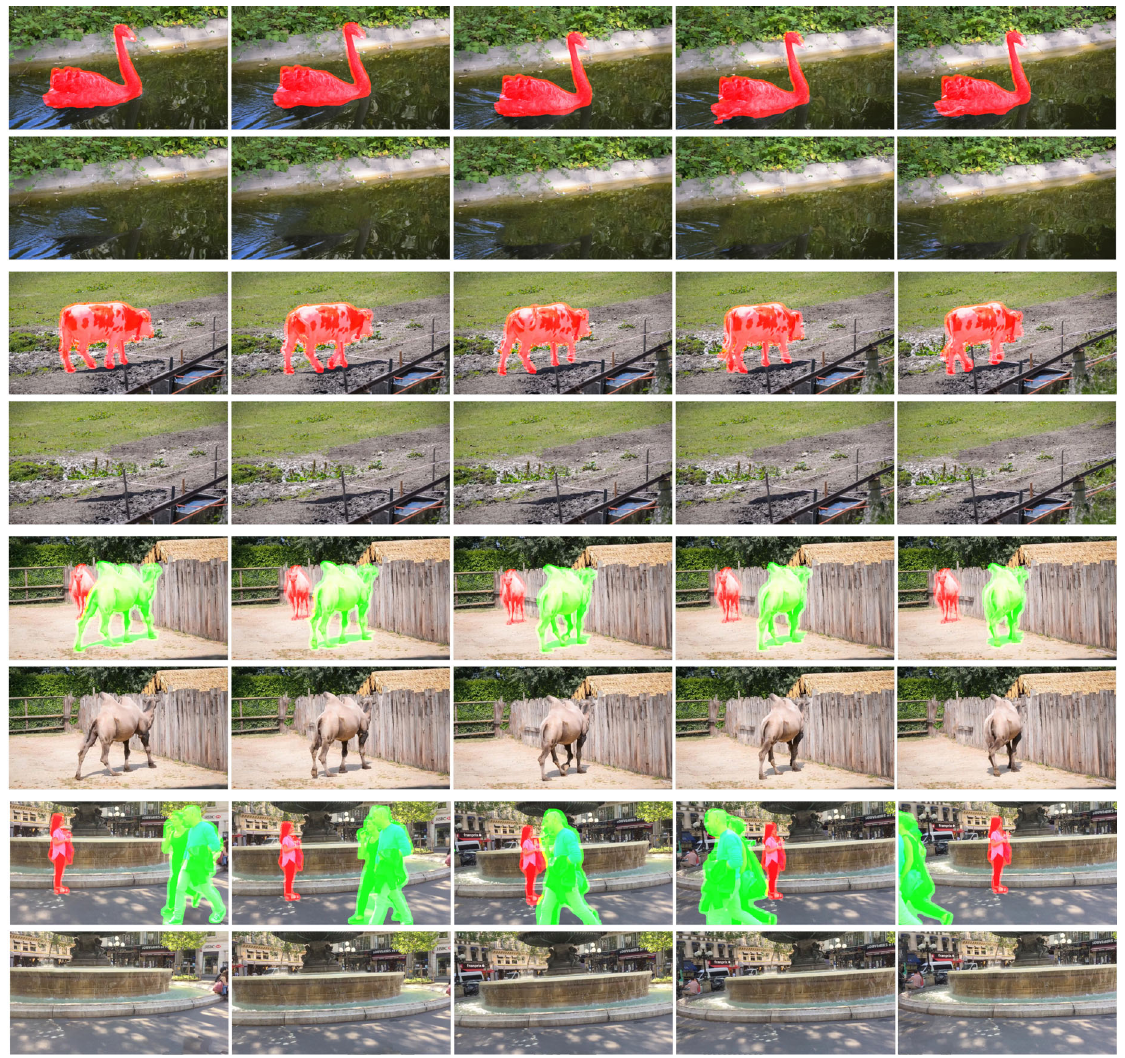
Fig. 9 Results from our object removal